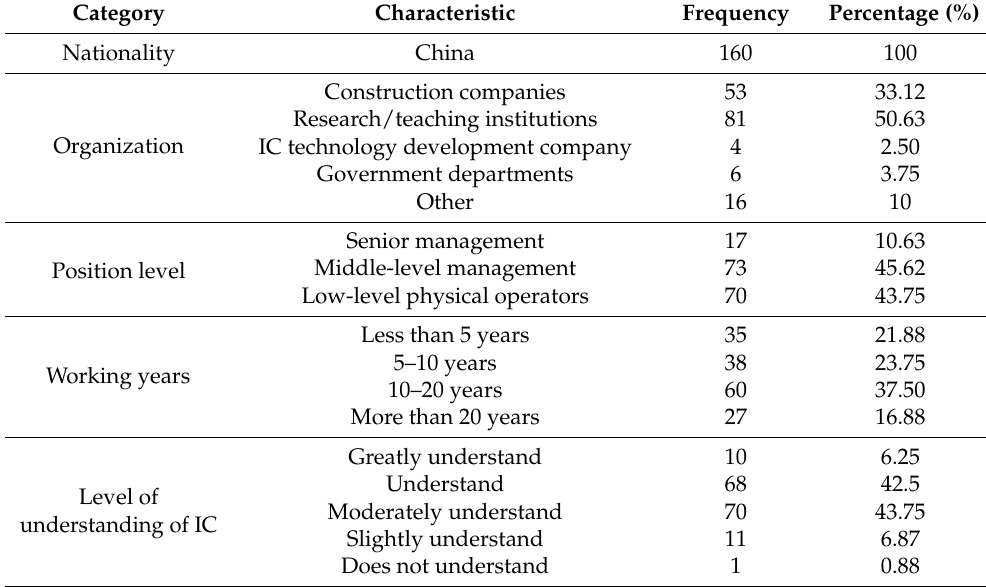
Table 2. Respondents’